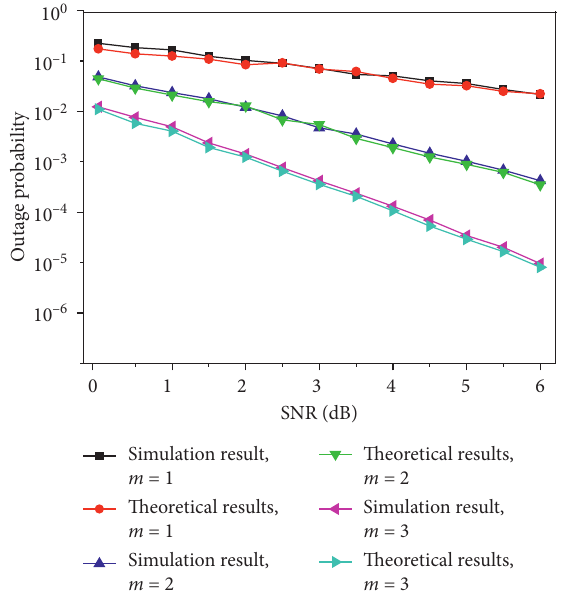
Figure 8: Comparison of simulation and theoretical outage probability results.